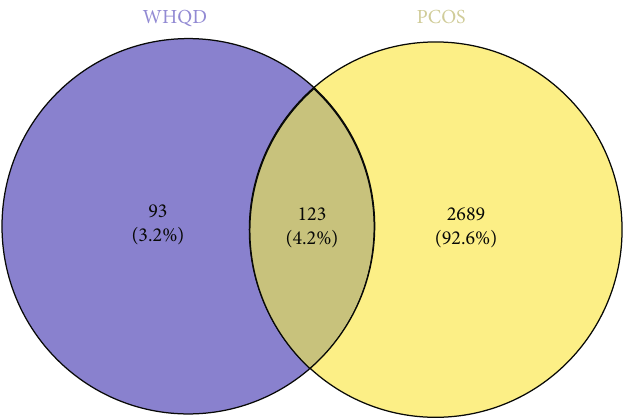
Figure 3: Venn diagram of common target genes.